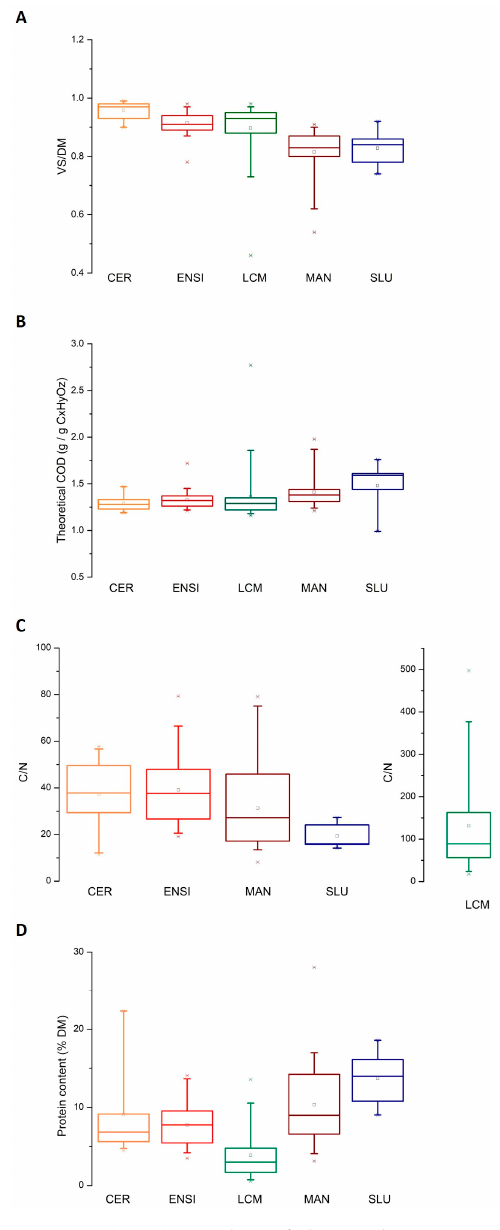
Figure 1. ( A – D ) Boxplots of chemical composition variabilities: VS/DM, COD, C/N, and protein content. Medians are the horizontal lines and means are represented by squares. Families: cereal residue (CER), energy crop and silage (ENSI), lignocellulosic matter (LCM), manure (MAN), and slurry (SLU).